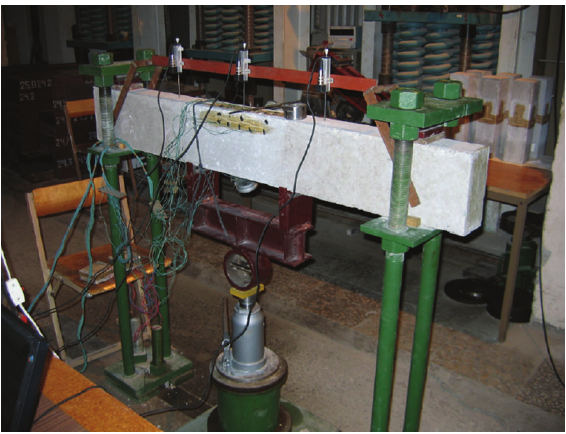
Figure 1: The test setup for concrete